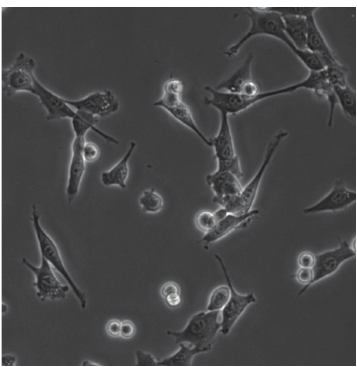
Figure 1: Bright field microscope image with approximately two dozen cells on a grey background. Some interior structure can be discerned in cells (including the cell membrane, the dark grey cytoplasm, and the lighter cell nucleus with dark nucleoli inside). Cells that are close to division appear as bright, nearly circular shapes. Some cells are touching, and some cell parts overlap. Our goal is to obtain separate segments for each cell in the